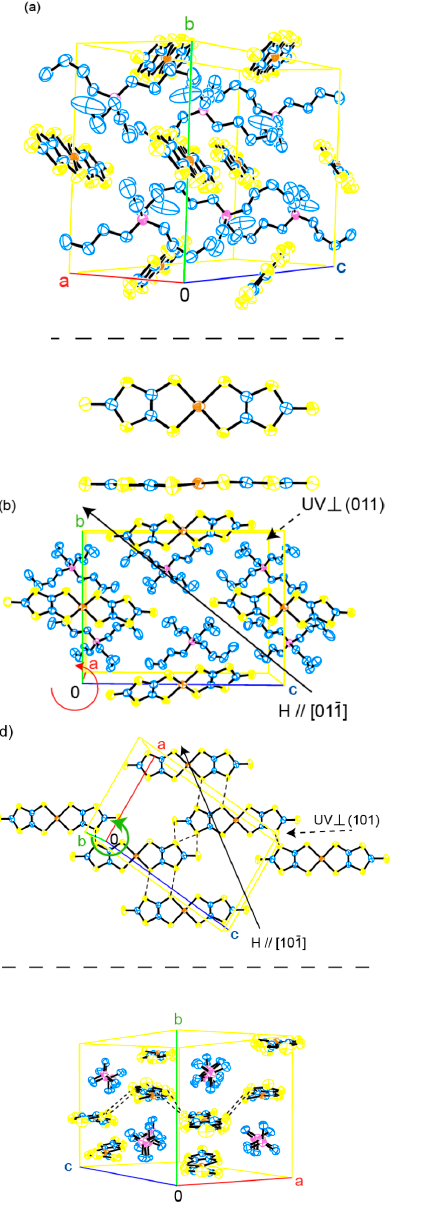
Figure 2. Crystal and molecular structures of 1 – 3 at 297 K: ( a , b ) 1 ; ( c , d ) 2 ; and ( e ) 3 . Yellow lines designate the edges of the unit cells. Hydrogen atoms are omitted for clarity. Yellow, blue, brown, pink and red octants designate S, C, Cu, N and O atoms, respectively. In ( d ), broken lines designate S–S short contacts, and only [Cu(dmit) 2 ] 2 − anions are drawn in order to show the conduction pathways in the ac -planes ( upper ). In ( e ), [Cu(dmit) 2 ] 2 − and BP 2 DBF 2+ are drawn separately in the upper and middle parts, respectively, for clarity. In ( b , d , e ), the directions of the magnetic fields ( H ), those of the UV irradiation and the rotation axes of the single crystals relative to H (circular arrows around the a -axis in 1 , around the b -axis in 2 and around the axis perpendicular to both the b - and c -axes in 3 ) in angle-dependent ESR measurements are shown.